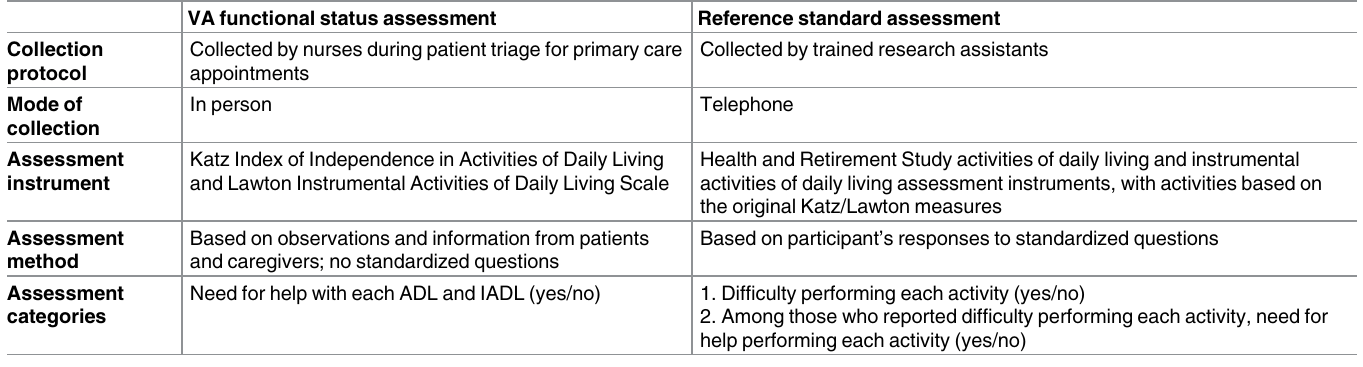
Table 1. Comparison of VA functional status assessmentto reference standard